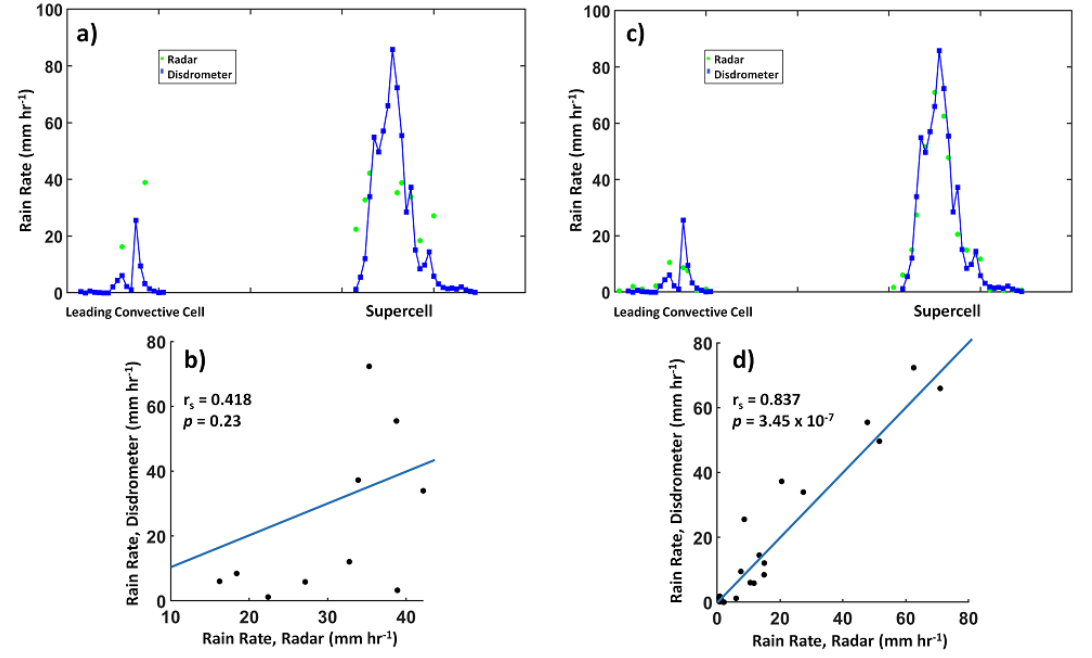
Figure 7. As in Figure 3, except for rain rate comparisons between radar and disdrometer datasets. ( a , b ) contain disdrometer measurements of rain rate compared with values estimated from the radar dataset using Equation (11), while ( c , d ) are a comparison between disdrometer measurements of rain rate and a radar-estimated value using Equation (10). Spearman’s correlation ( r s ) is indicated along with its p -value.